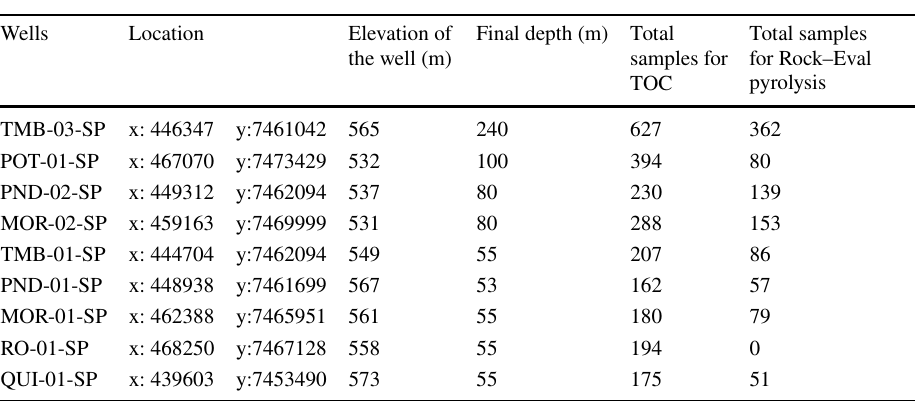
Table 1 Information regarding the wells studied